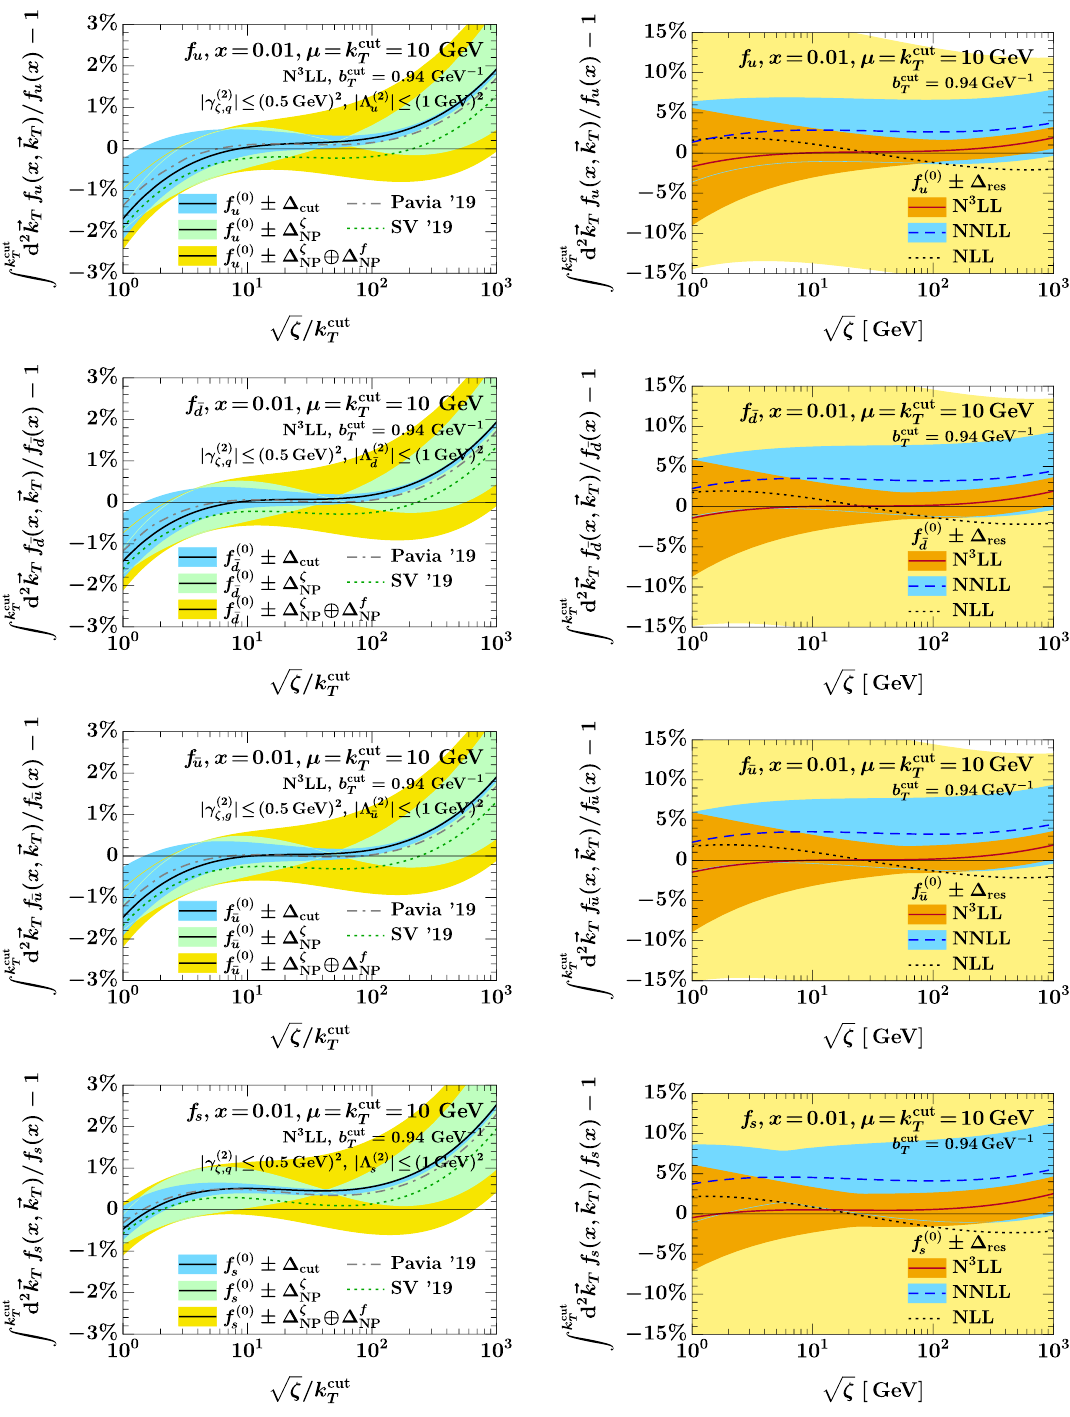
Figure 15 . Same as figure 9, for i = u, ¯ d, ¯ u, s